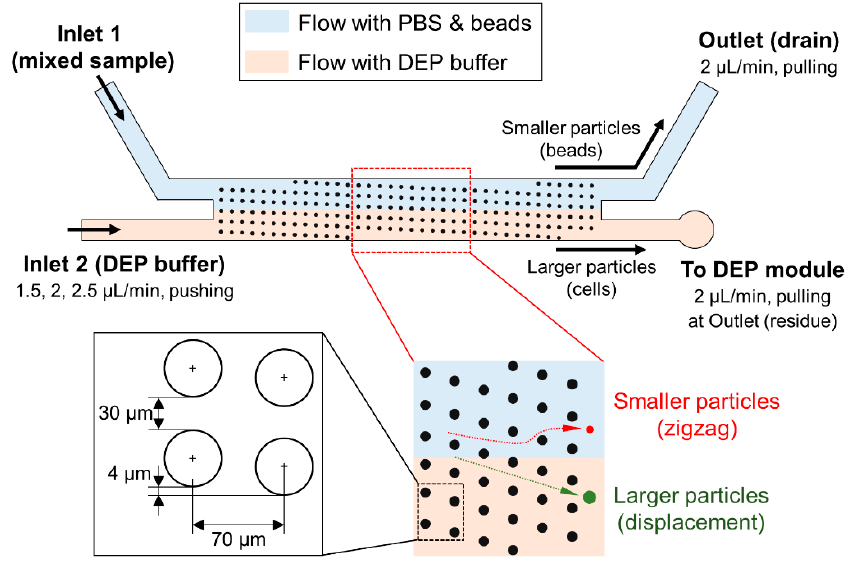
Figure 3. Details of the deterministic lateral displacement (DLD) module and details of pillar structures.